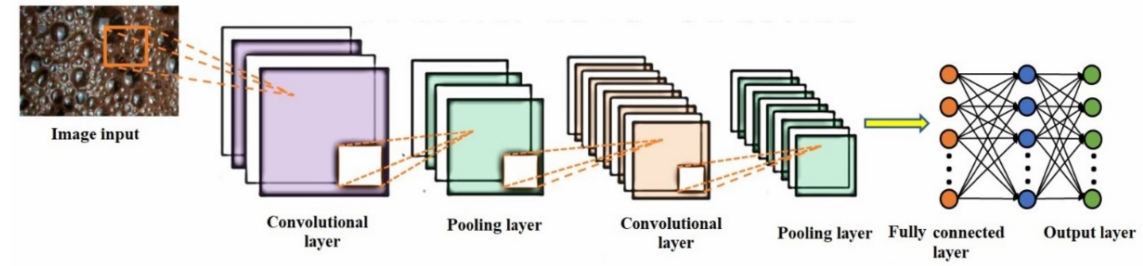
Figure 5. The structure of the CNN model.